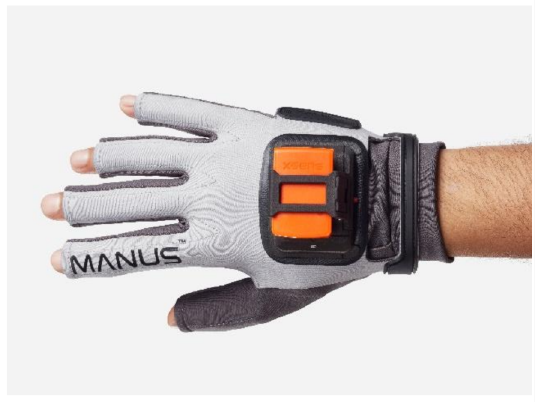
Figure 30. Manus Prime II Xsens)